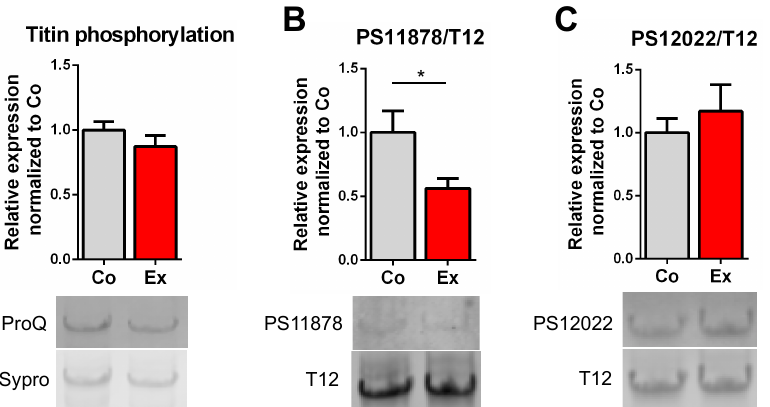
Figure 2. Effect of long-term exercise on titin phosphorylation. ( A ) Total titin phosphorylation did not differ between control and exercised rats. ( B ) Exercise caused hypophosphorylation of titin’s S11878 (S26) site (linear contrast adjustment was applied to the original PS11878 image for better visualization), ( C ) but had no effect on S12022 (S170). n = 6/group, * p < 0.05. Sypro: Sypro Ruby Protein Gel Stain, T12: anti-12 antibody detecting titin’s